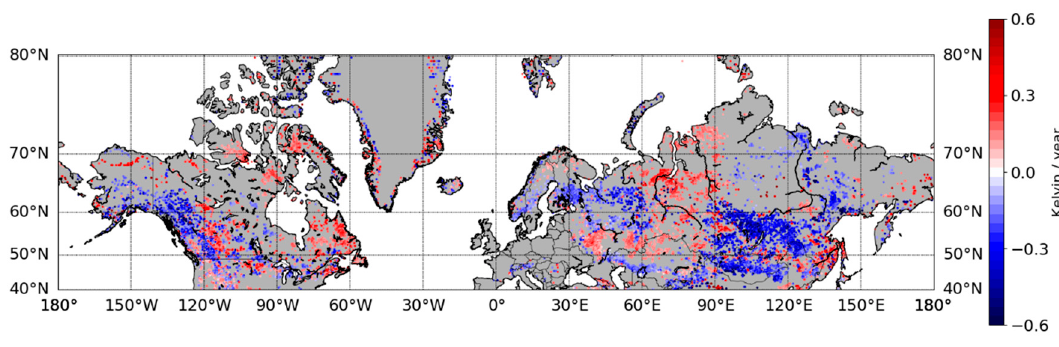
Figure 6. ( a ) The rates of change for the albedo after melt season (absolute albedo % per year) between 1982 and 2015 using 5-year rolling mean albedo (showing cases for which R 2 of the fit was larger than 0.5). ( b ) The coefficient of determination ( R 2 ) value for trends in albedo after the end of melt.